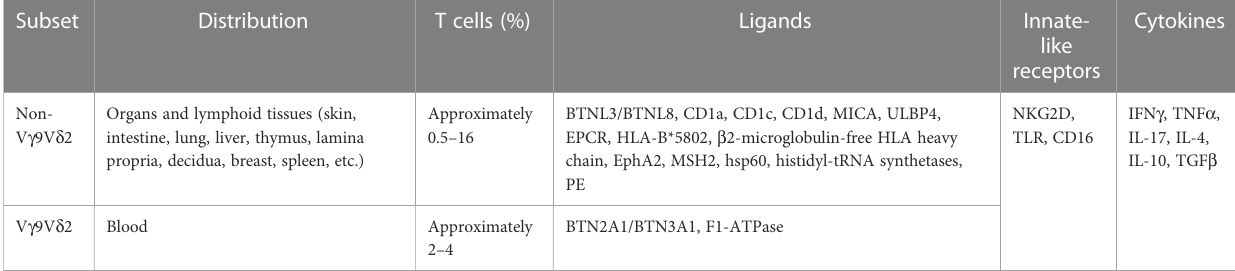
TABLE 1 Main features of human gd T cells. Subset Distribution